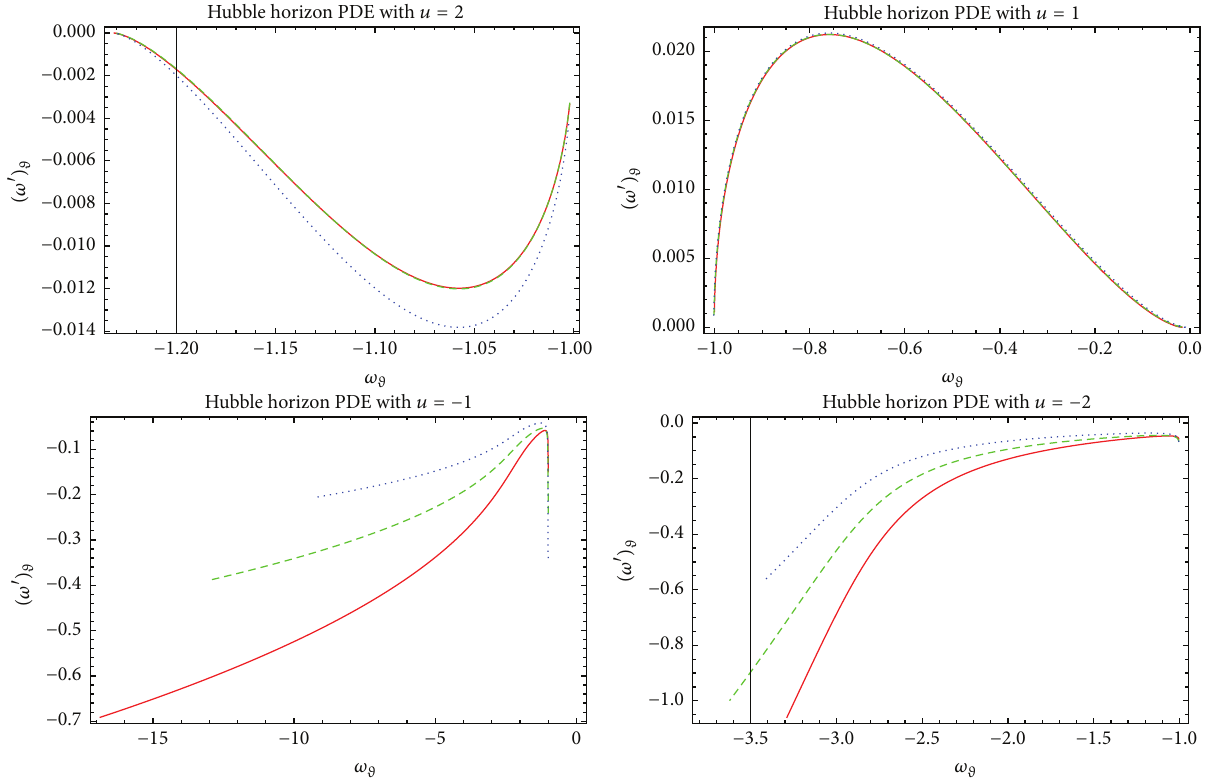
Figure 5: Plots of 𝜔 𝜗 - 𝜔 󸀠 𝜗 for Hubble horizon PDE model in dynamical Chern-Simons gravity with 𝑢 = 2, 1, −1,−2